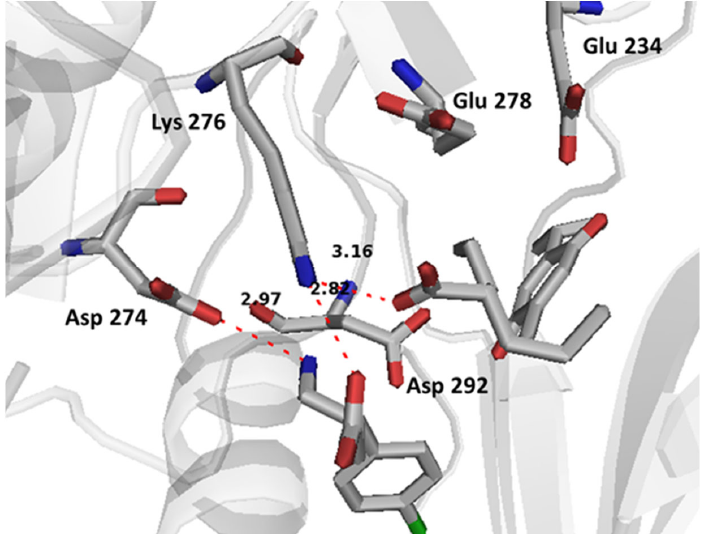
Figure 10. Binding interactions of co ‐ bound ternary supramolecular complex of SVP, BFN and THQ with Akt allosteric site and active site. The distances are represented by red dotted lines, and are measured in Angstrom.